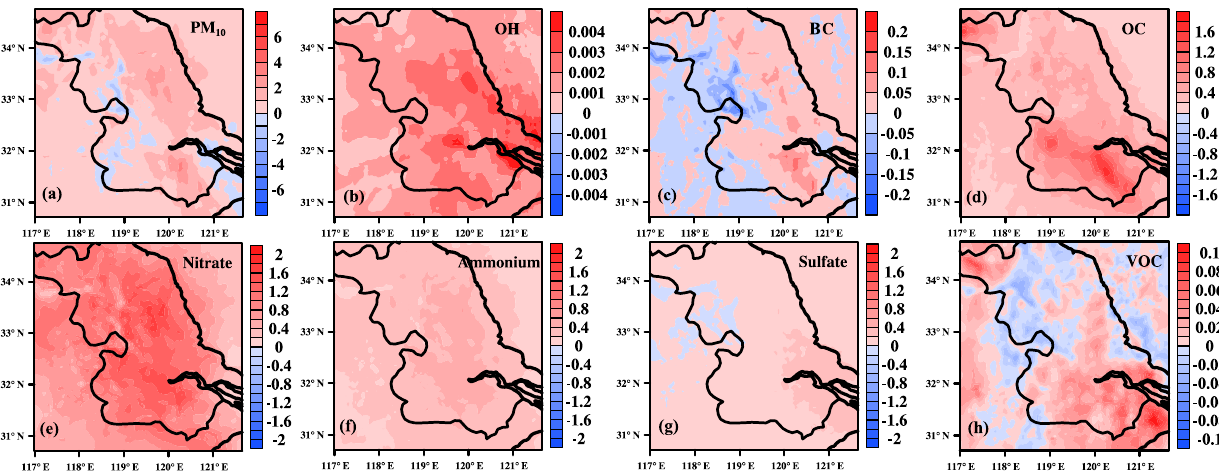
Figure 4. Differences in chemical species between MOD2 and MOD1 in December 2013. Unit: “pptv” for OH; “ppmv” for VOC; “µgm − 3 ”for the